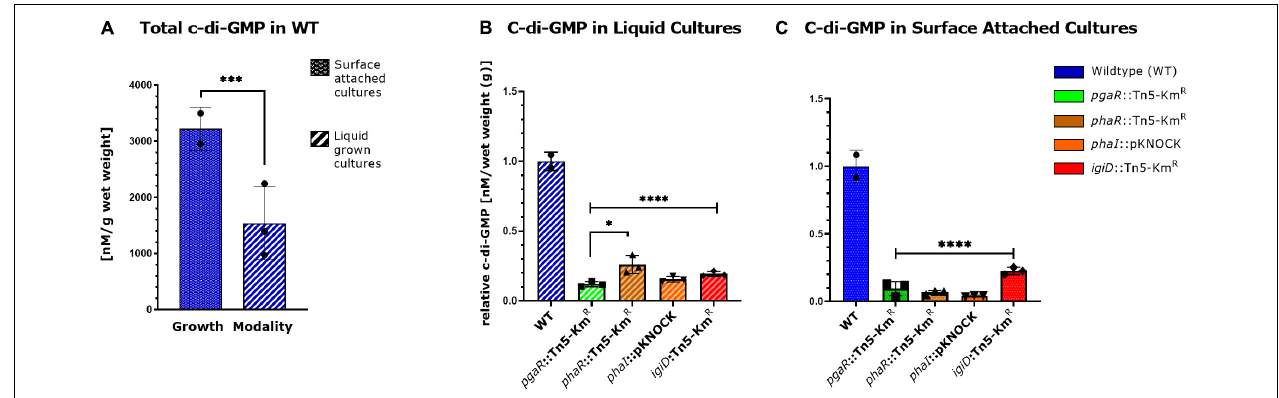
FIGURE 4 | Cyclic-di-GMP concentrations in broth and agar grown cultures. A comparison of intracellular cyclic-di-GMP concentration in WT cultures grown on agar and in broth culture (A) . Intracellular c-di-GMP concentration of Y4I variants grown on broth (B) and in agar culture (C) are shown. Each data point represents the average of three technical replicates. Error bars represent the standard deviation of the mean. Asterisks represent statistical significance [ p < 0.05 ( ∗ ), 0.001 ( ∗∗∗ ), 0.0001 ( ∗∗∗∗